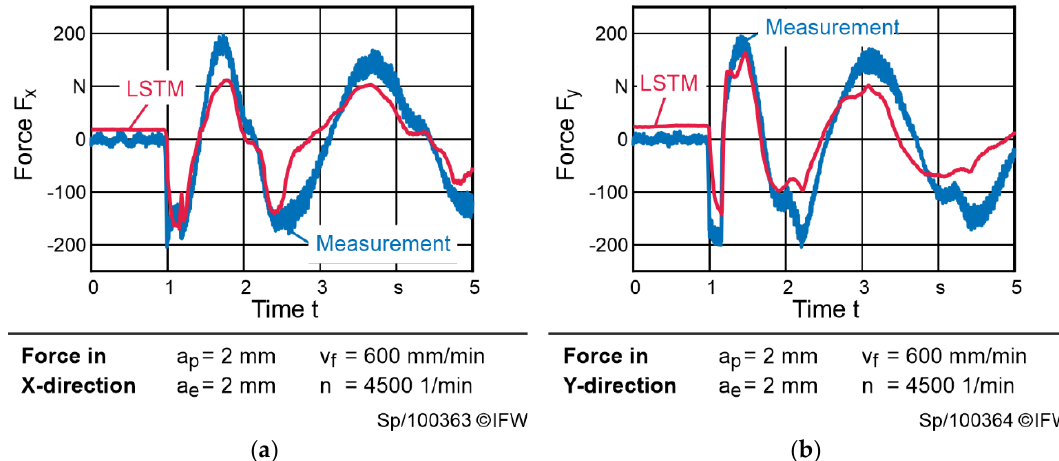
Figure 7. Comparison between measured process forces and the result of the LSTM during milling of a circular pocket: ( a ) force acting in X -direction; ( b ) force acting in Y -direction. Analyzing the RMSE and comparing it to the model-based approach, in most cases the LSTM outperforms the model-based approach. An overview of the RMSE of both models is given in Table 2, showing different evaluated milling processes of the test set. The test set covers straight side milling processes with different process parameters as well as ramp milling (indicated with the – y /+ z feed direction) and circular pocket milling with a counterclockwise (ccw) feed direction. Table 2. RMSE of the LSTM compared to the model-based approach and the measured forces F me. Feed